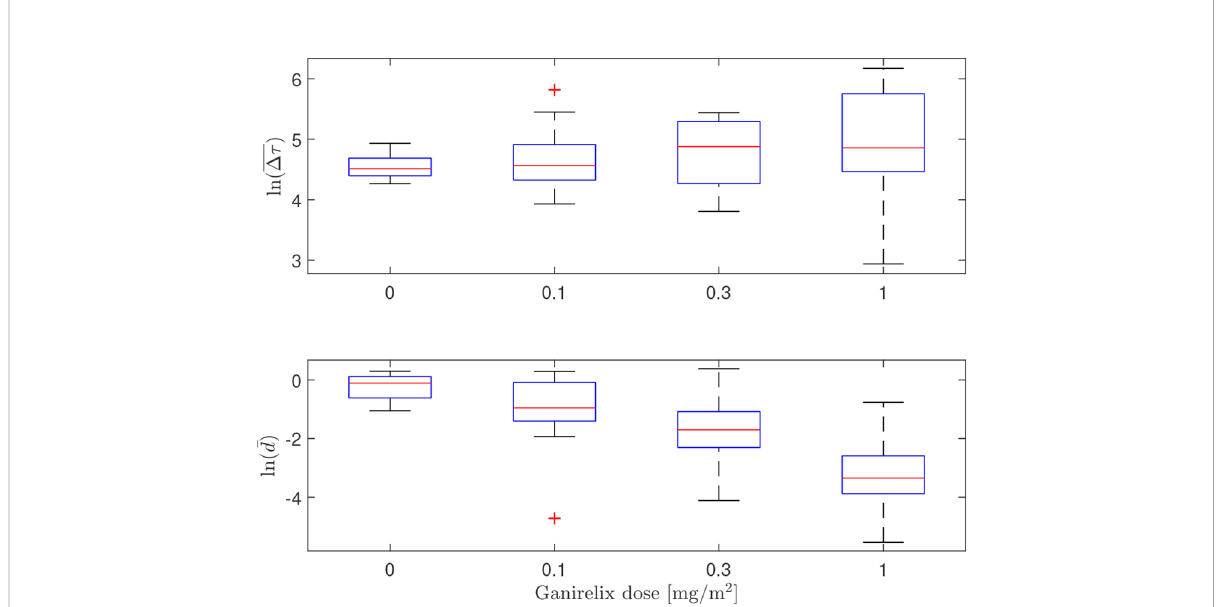
FIGURE 9 Box plot illustrating the distributions of estimated average impulse separation time (top) and impulse weights (bottom) for escalating doses of ganirelix administered to fi fteen test subjects. Median values are indicated by the center line, the 25th and 75th percentiles are given by the box edges, whiskers show the most extreme values not considered outliers and outliers are marked by red crosses. Notice logarithmic scale on the ordinate axes.